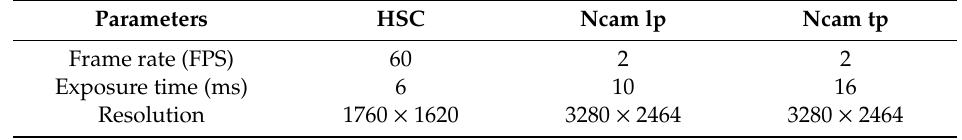
Table1. Initializationparameters ofHSC,Ncam lp, and Ncamtpfor theperformancetesting experiment.